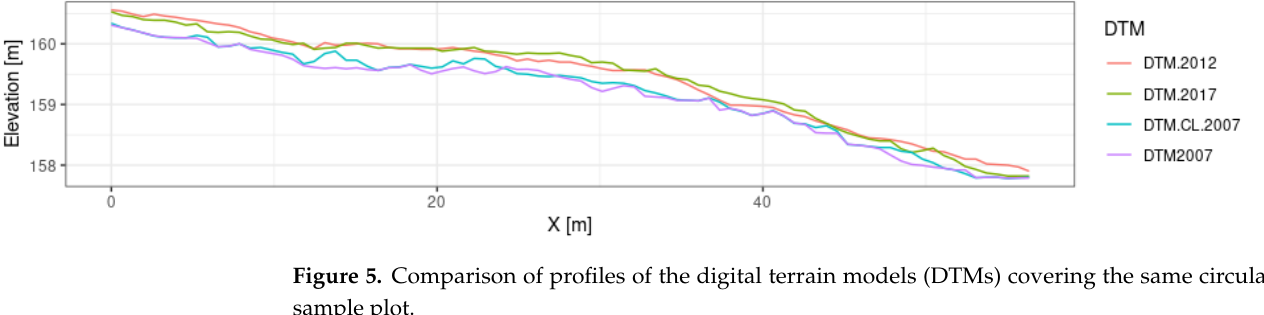
Figure 6. ALS data processing procedure for obtaining height measurements of individual Scots pine trees from each of the three scannings and verification of the tree height increment values.